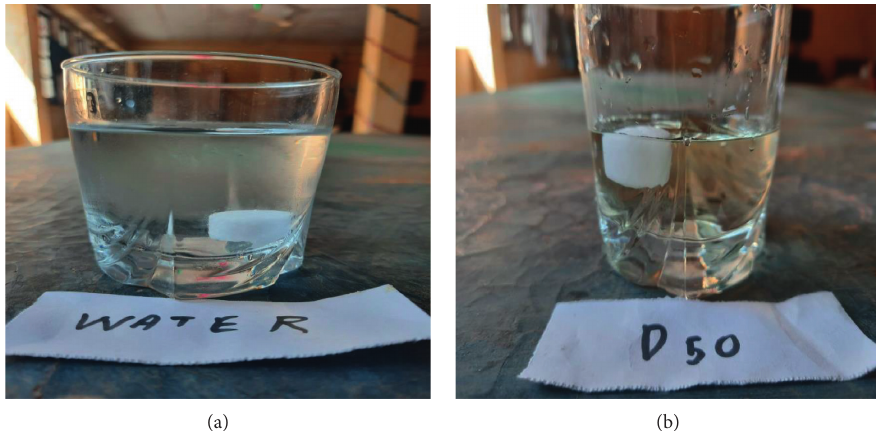
Figure 1: While camphor floats in water, both paradichlorobenzene and naphthalene will sink. In 50% dextrose, both naphthalene and camphor will float, while paradichlorobenzene will sink.